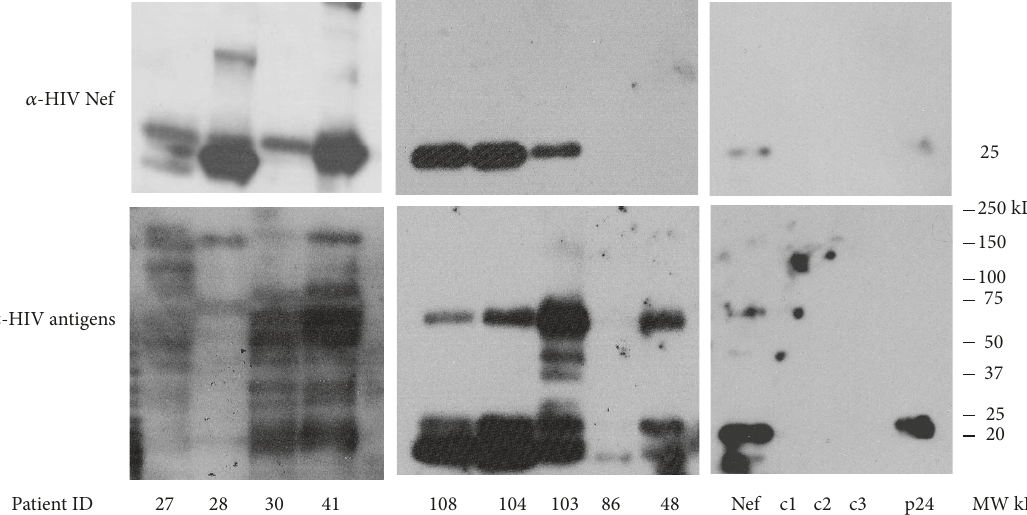
Figure 1: Detection of HIV-1 proteins by western blot . Extracellular vesicles were isolated from four ml of urine from HIV-1+ patients and HIV-1 negative individuals by Amicon ultrafiltration (MW cutoff = 100,000 kD). The western blot is representative of 9 HIV+ and 3 HIV- negative samples (c1, c2, and c3). Recombinant HIV Nef and p24 were added as positive controls (last panels on the right). Samples were isolated in a 4–20% gradient SDS gel and transferred to a PVDF membrane. The filter was incubated with the primary antibody, pooled HIV-1 positive plasma (bottom panels), or a monoclonal anti-HIV Nef (top panels). The secondary antibody, goat anti-mouse IgG for the anti-Nef blots or rabbit anti-human IgG for the anti-HIV antibodies, conjugated to horseradish peroxidase. Super Signal West Femto was used as chemiluminescent substrate for detection.